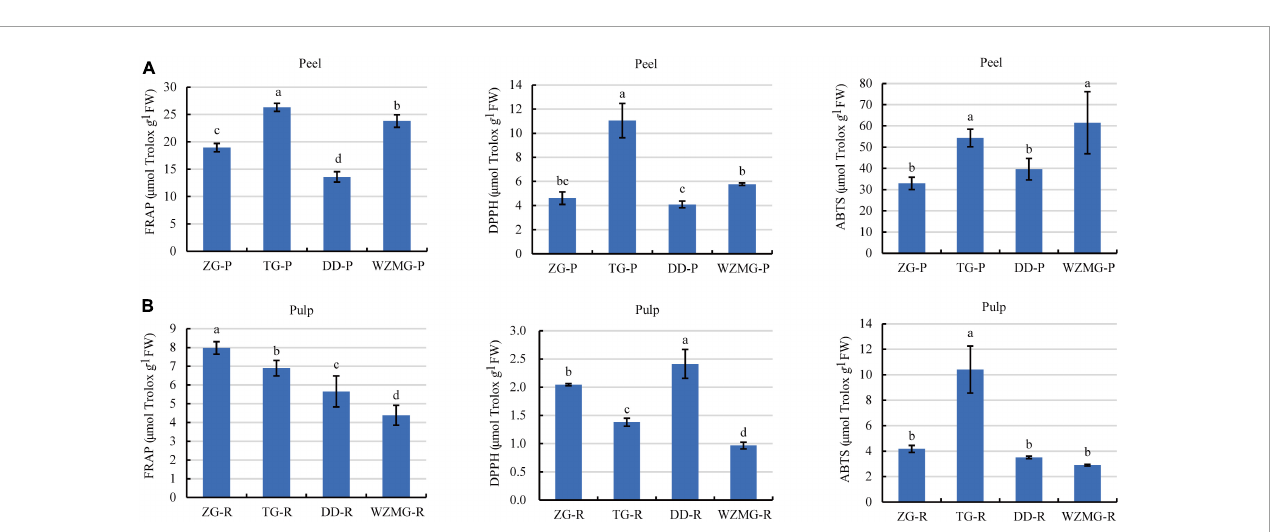
FIGURE6 Comparative analysis of antioxidant activity of peel and pulp. (A) FRAP activity, DPPH scavenging activity, and ABTS scavenging activity of ZG-P, TG-P, DD-P, and WZMG-P. (B) FRAP activity, DPPH scavenging activity, and ABTS scavenging activity of ZG-R, TG-R, DD-R, and WZMG-R. The different letters in each bar indicate significant differences by Tukey’s test ( P < 0.05). FRAP, DPPH, and ABTS value were expressed as µ mol Trolox equivalents/g FW. FW, fresh